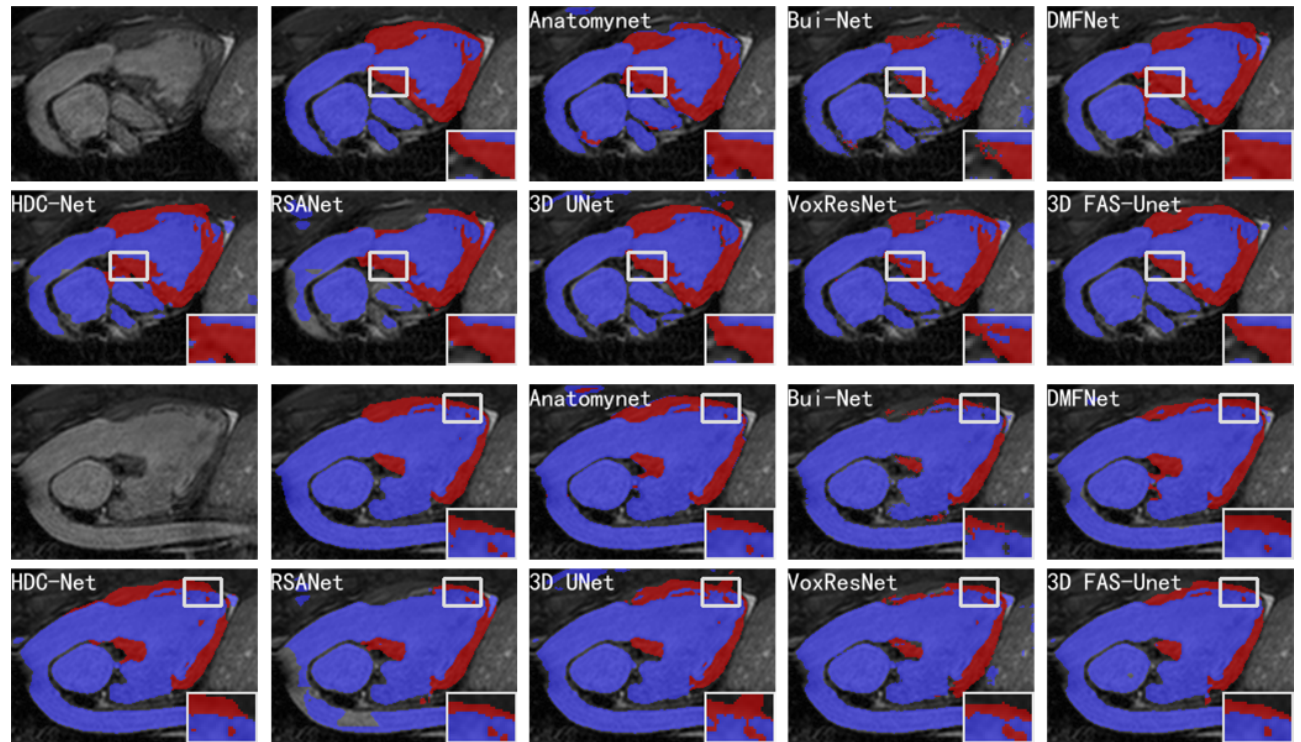
Figure 4. Visualizations of different methods for cardiovascular MR segmentation of different slices. From left to right in the first and third rows: the original images, the ground-truth, and the segmentation results of AnatomyNet, Skip-connected 3D DenseNet, and DMFNet, respectively. From left to right in the second and fourth rows: the segmentation results of HDC-Net, RSANet, 3D UNet, VoxResNet, and 3D FAS-UNet, respectively. The blue and red colors represent blood pool and myocardium,